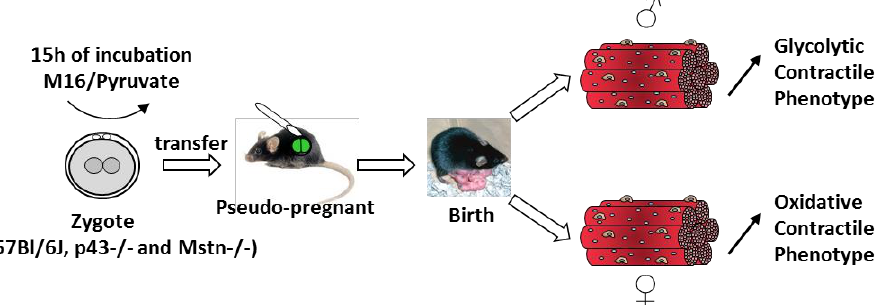
Figure 8. Schematic representation of the influence of pyruvate treatment of embryo at one cell stage on skeletal muscle phenotype.